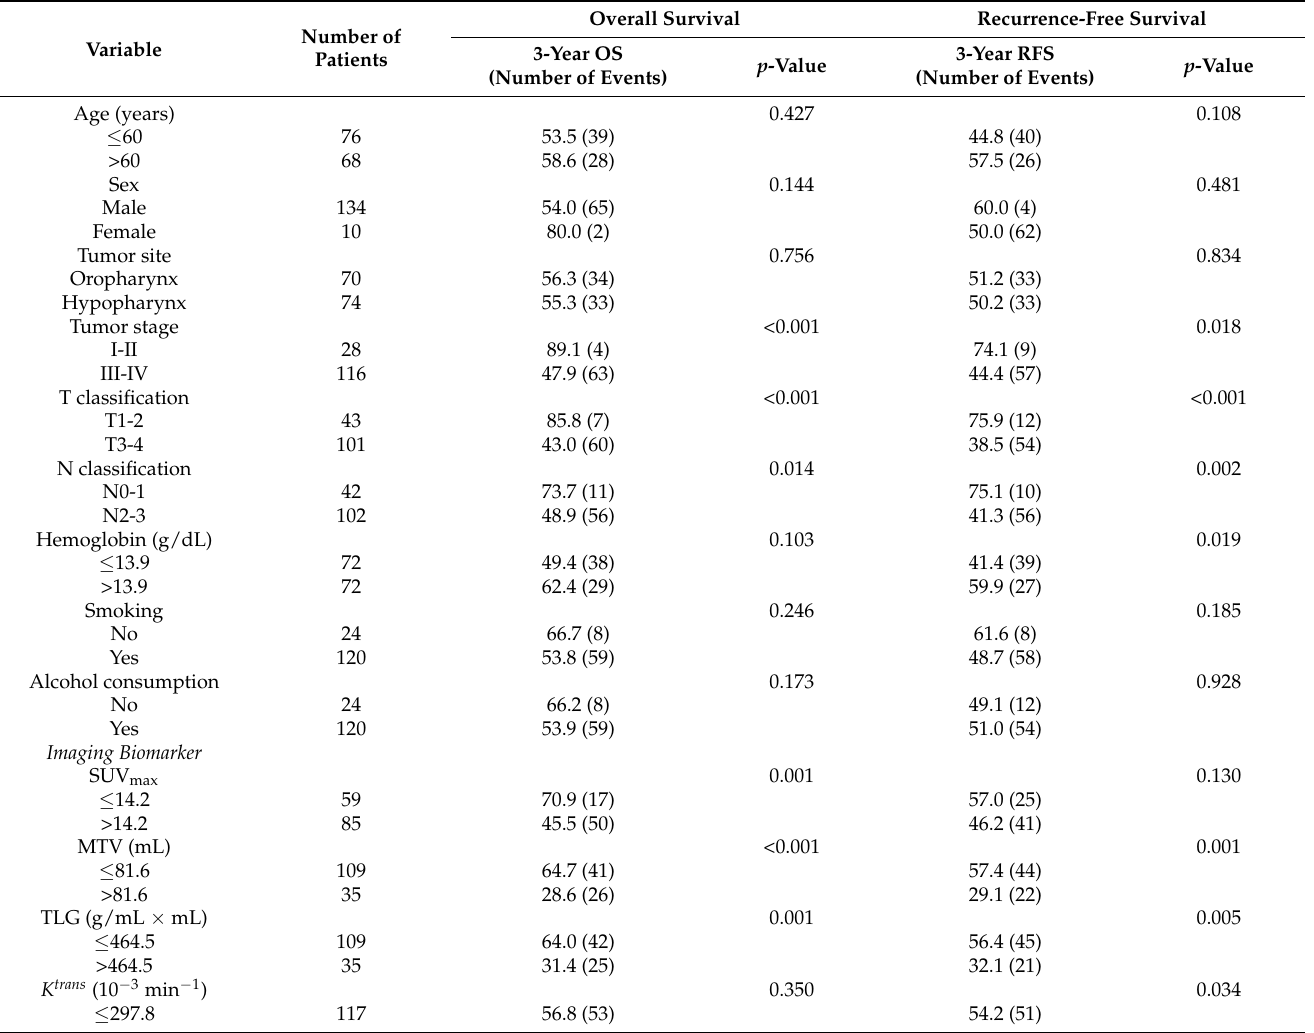
Table 3. Univariate analysis of clinical factors and PET/MRI biological imaging markers in relation to overall survival and recurrence-free survival in patients with oropharyngeal or hypopharyngeal squamous cell